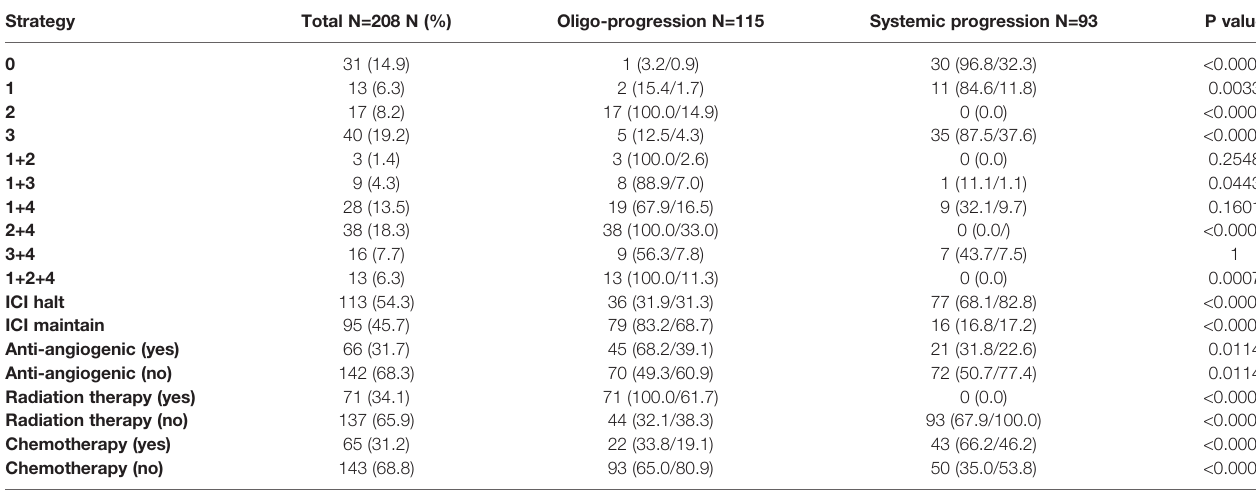
TABLE 3 | Sequential therapy beyond immunotherapy resistance.